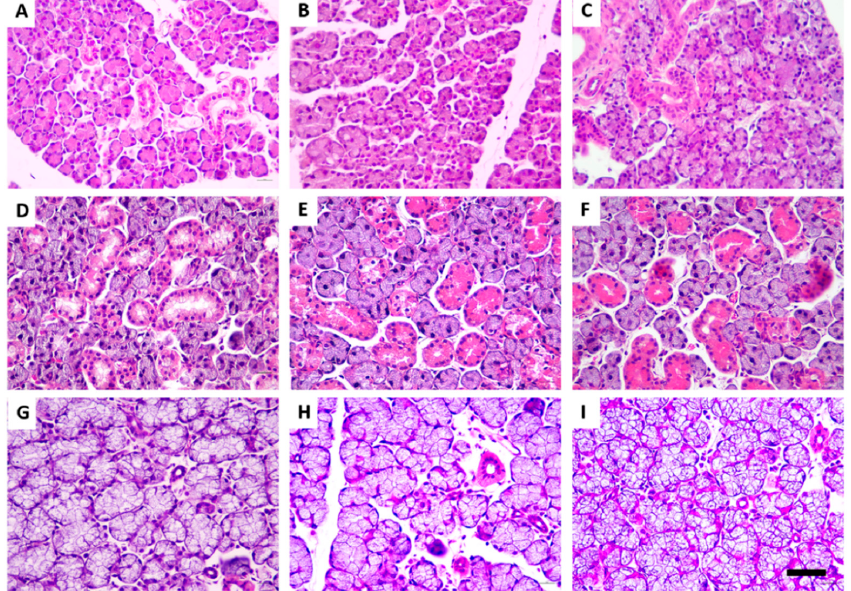
Figure 2. Effects of 60-day exposure to 0, 10, or 50 mg F/L from the drinking water on the histologic characteristics of the salivary glands of mice. Photomicrographs were obtained from the parotid ( A – C ), submandibular ( D – F ), and sublingual ( G – I ) glands, which were stained with hematoxylin and eosin. From left to right, exposure to 0 mg F/L (control), 10 mg F/L, and 50 mg F/L. 50 µm scale bar. ( n = 8 animals/group).